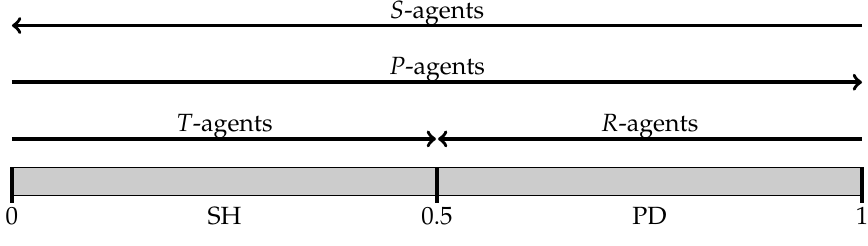
Figure 4. Updating thresholds by imitation for the four single-type choice